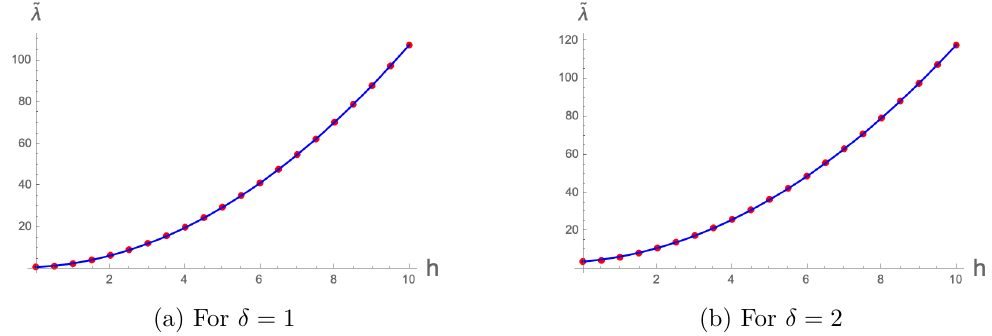
Figure 8. For numerical λ values with the fitting function in terms of h for δ = 1 , 2